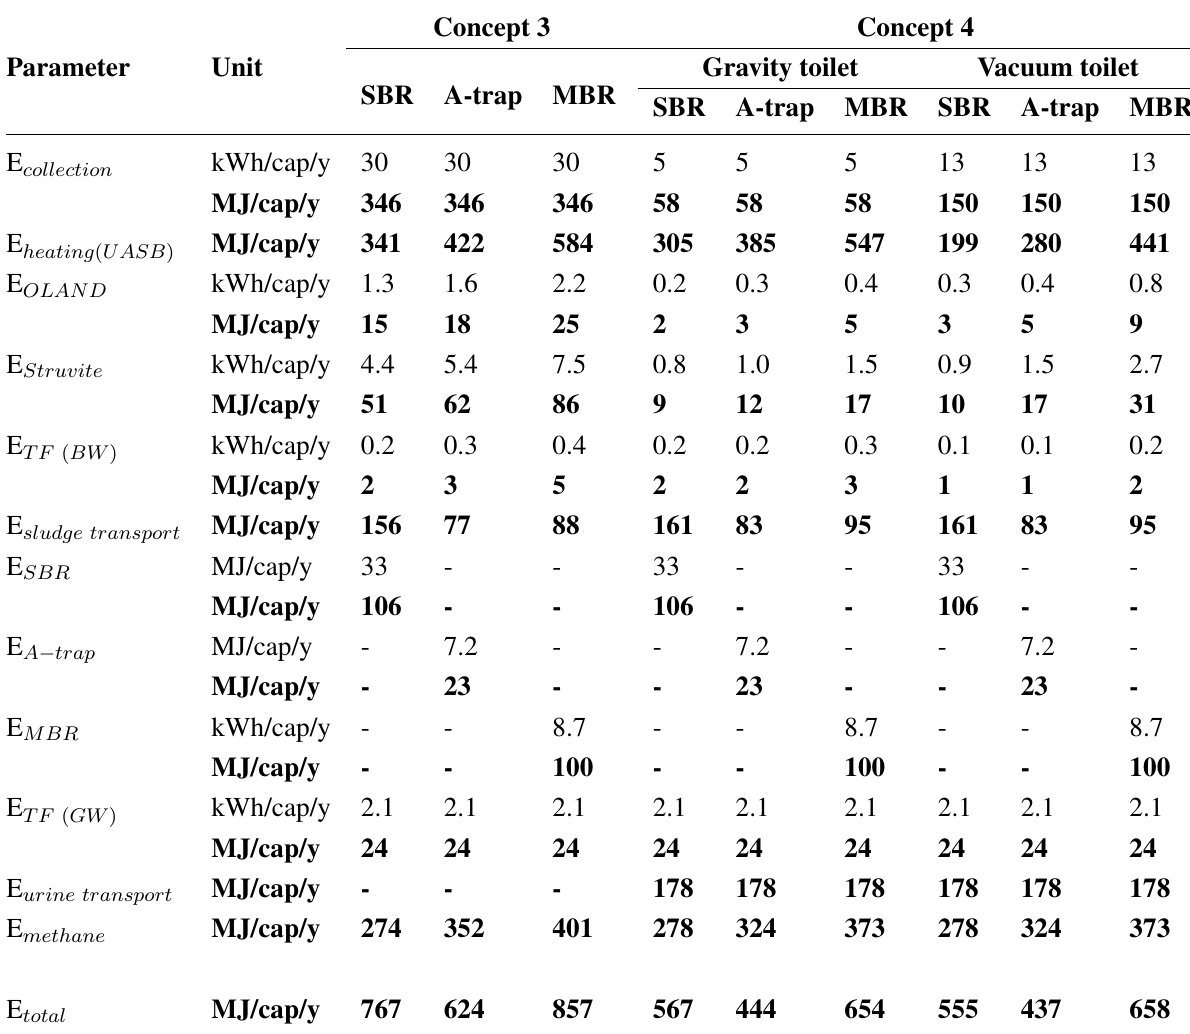
Table A3. Energy consumption and production (methane) in Concepts 3 and 4 (primary energy presented as bolded figures) (UASB = up-flow anaerobic sludge blanket reactor, OLAND = oxygen limited anaerobic nitrification denitrification, struvite precipitator, TF = trickling filter, SBR = sequencing batch reactor (SBR), A-trap = A-stage of AB-process and MBR = membrane